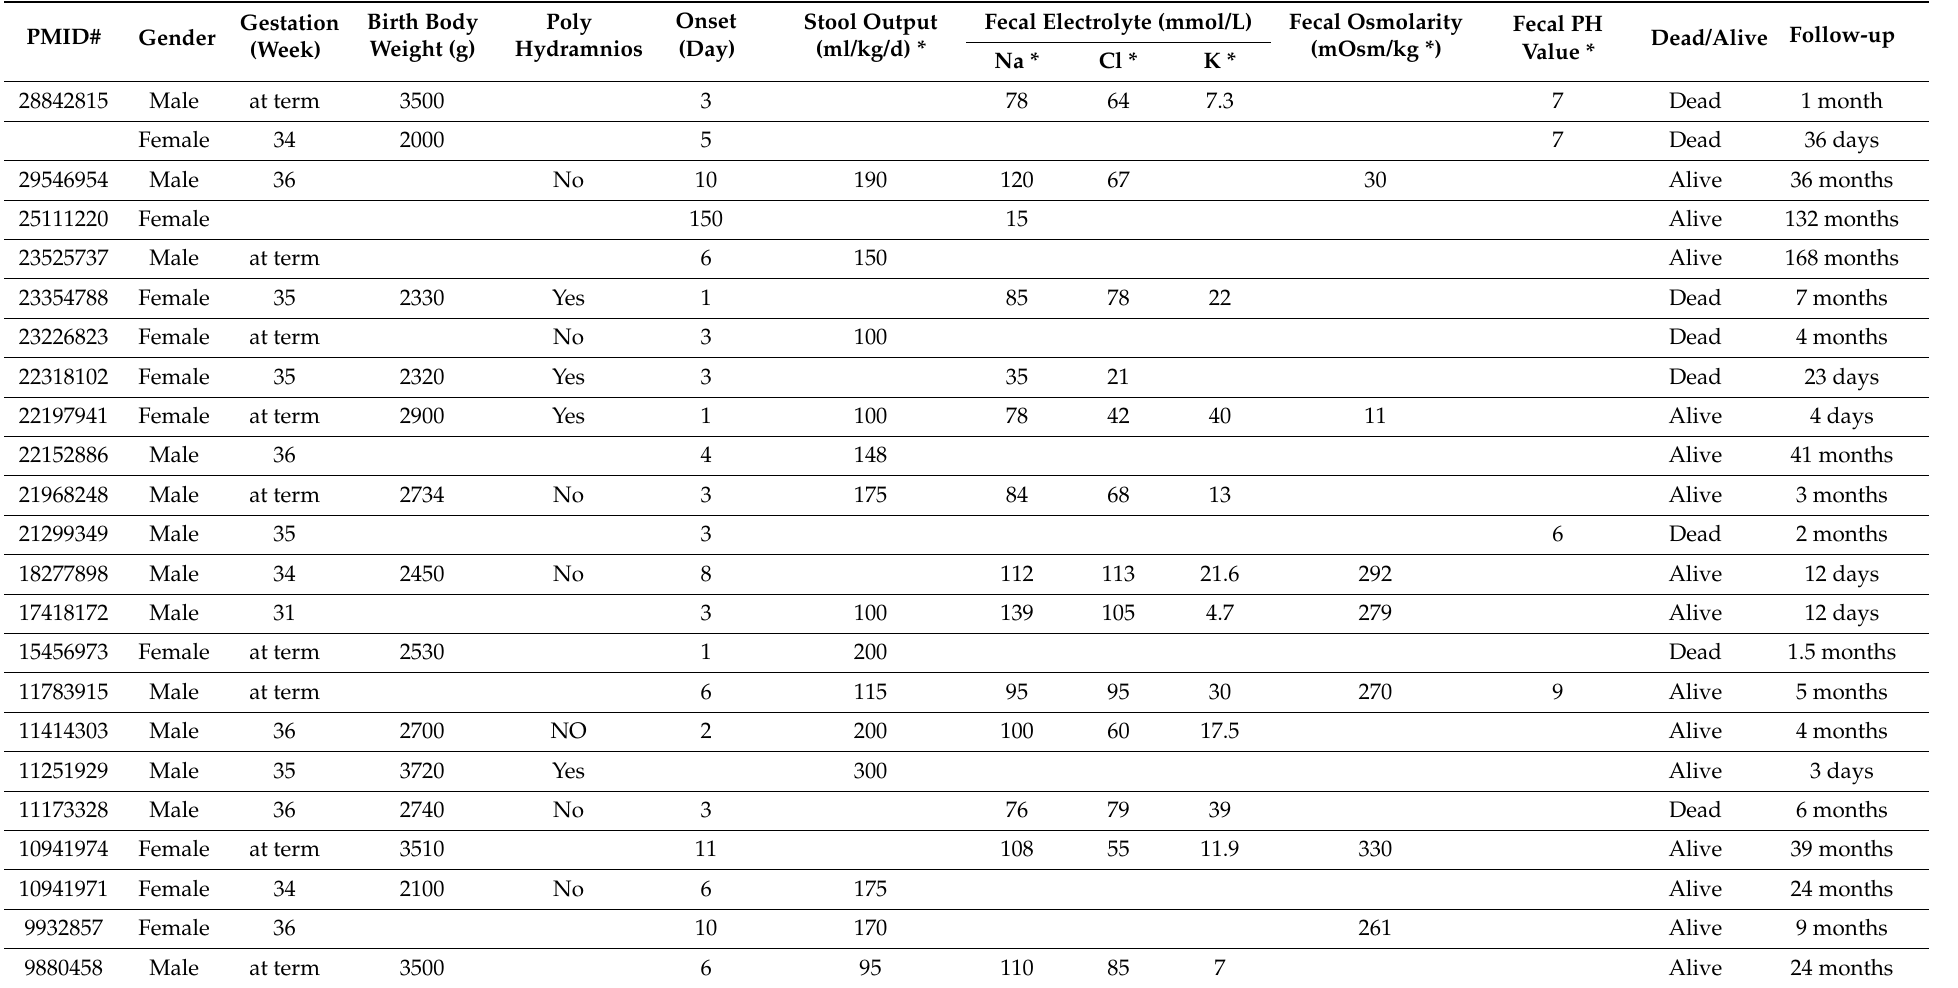
Table 1. Clinical details from published microvillus inclusion disease (MVID) case